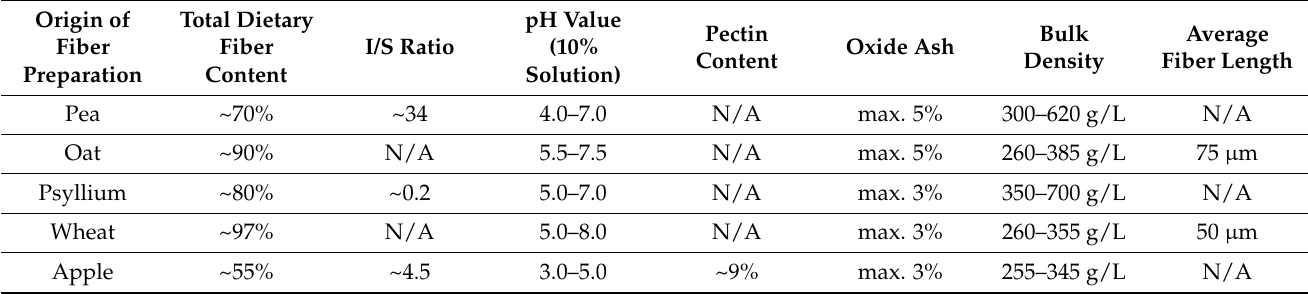
Table 1. Composition of the used concentrated fiber preparations in the FS